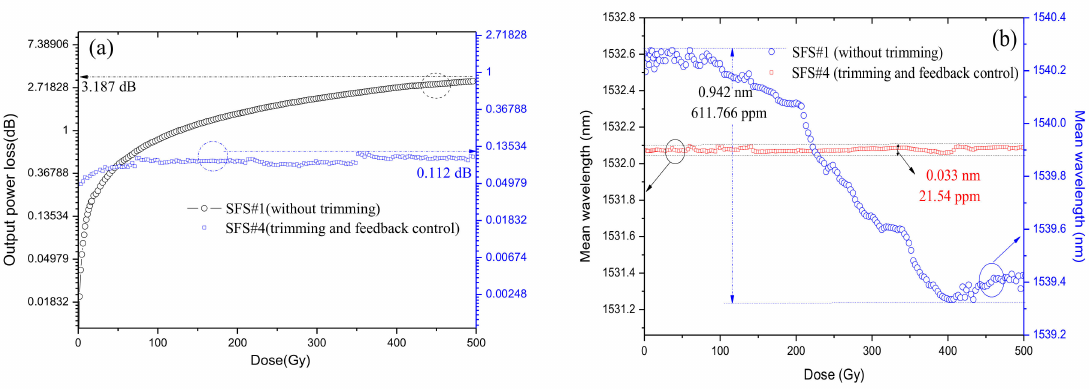
Figure 10. Experimental results of SFS#4 of ( a ) output power loss and ( b ) mean wavelength shift under Gamma ray irradiation of 500